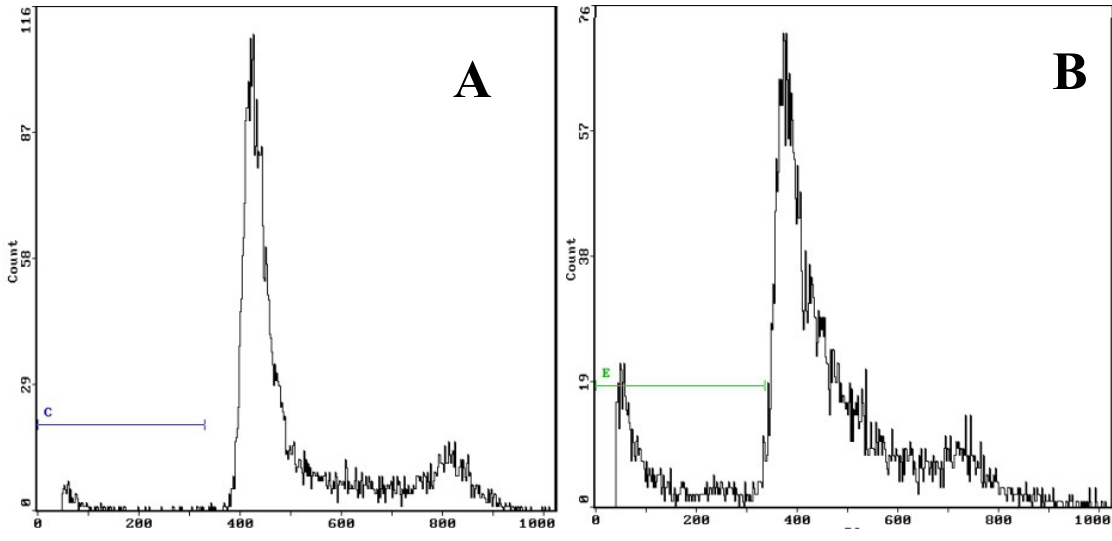
Figure 3. Effects of each group on apoptosis in in CNE2